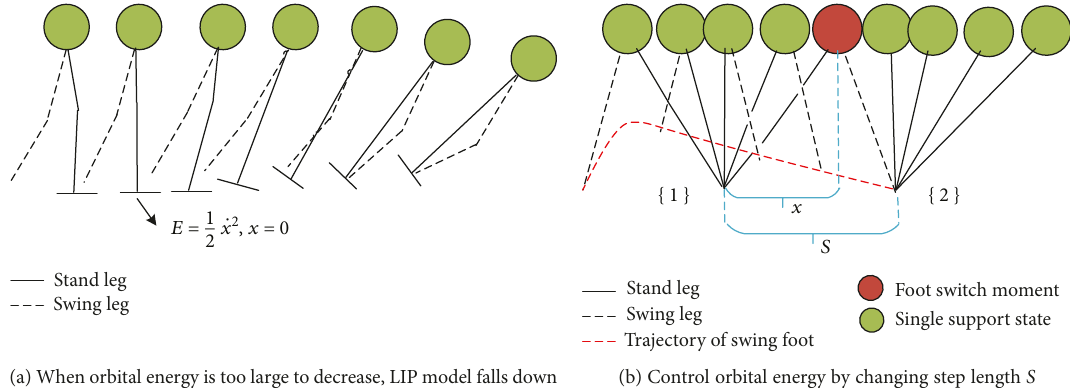
Figure 5: De fi nition of balance with orbital energy.